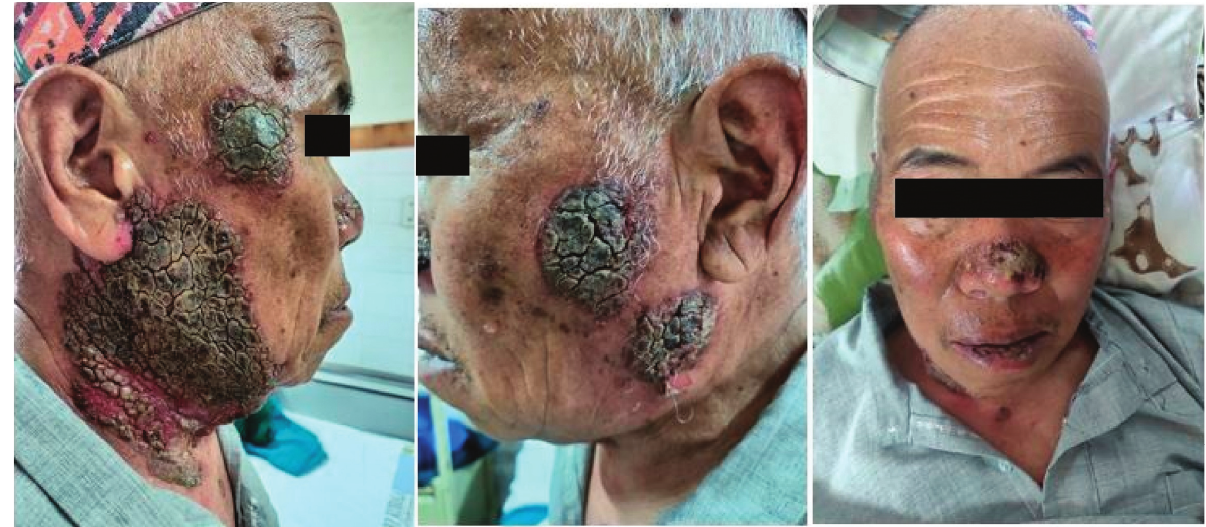
Figure 1: 8 months prior to admission: hyperkeratotic plaque and